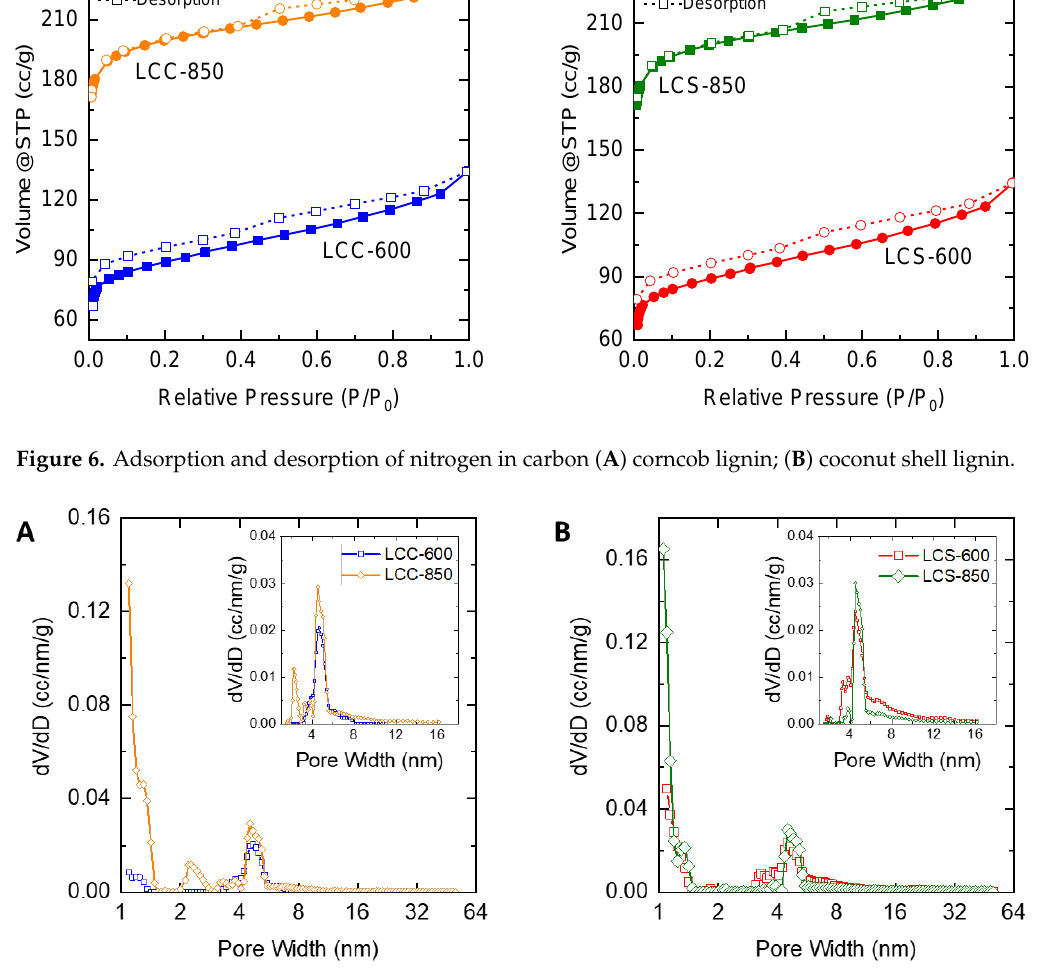
Figure 7. QSDFT-N 2 pore size distribution of carbon ( A ) corncob lignin; ( B ) coconut shell lignin.